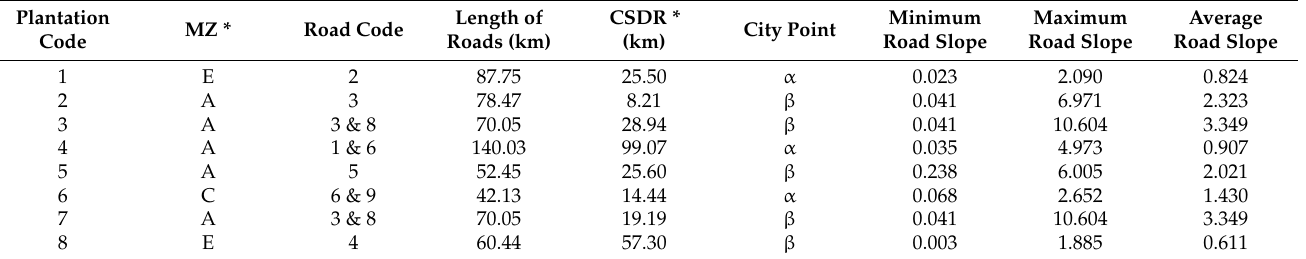
Table 3. Characteristics of the existing road network, as connected to the current forest plantations.